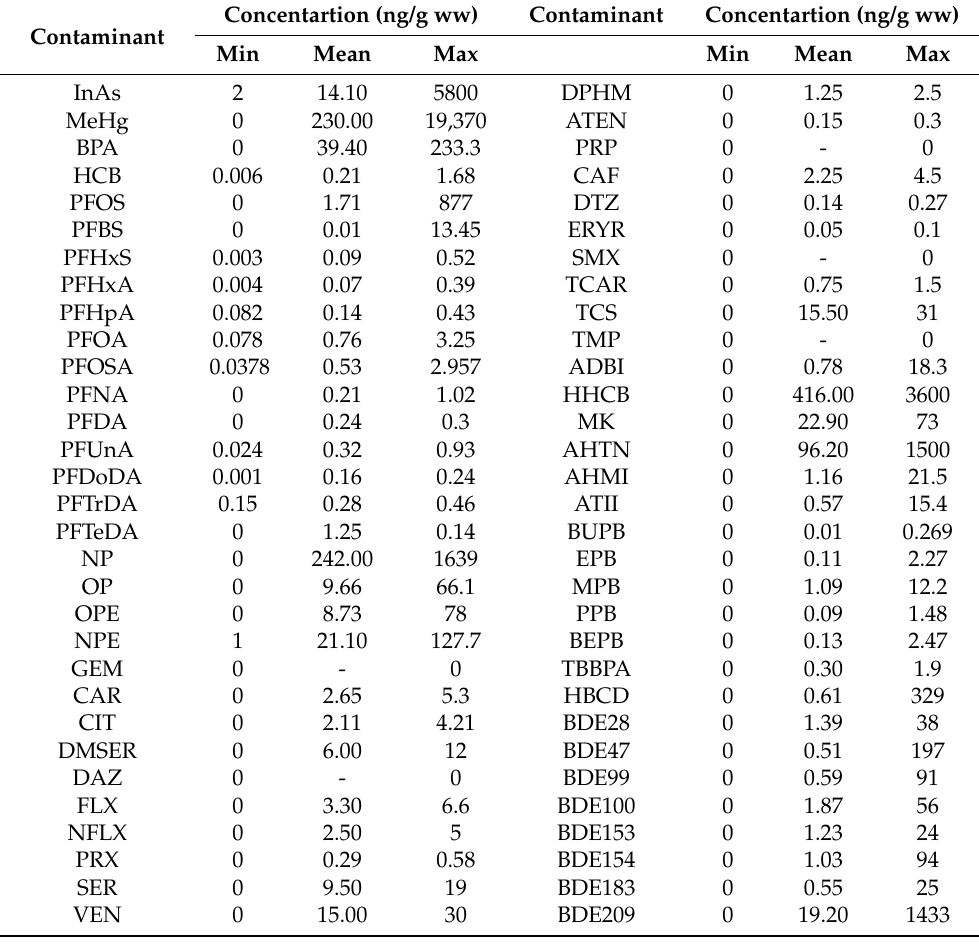
Table 2. Concentration values of selected emerging contaminants in seafood species (units in ng/g wet weight).